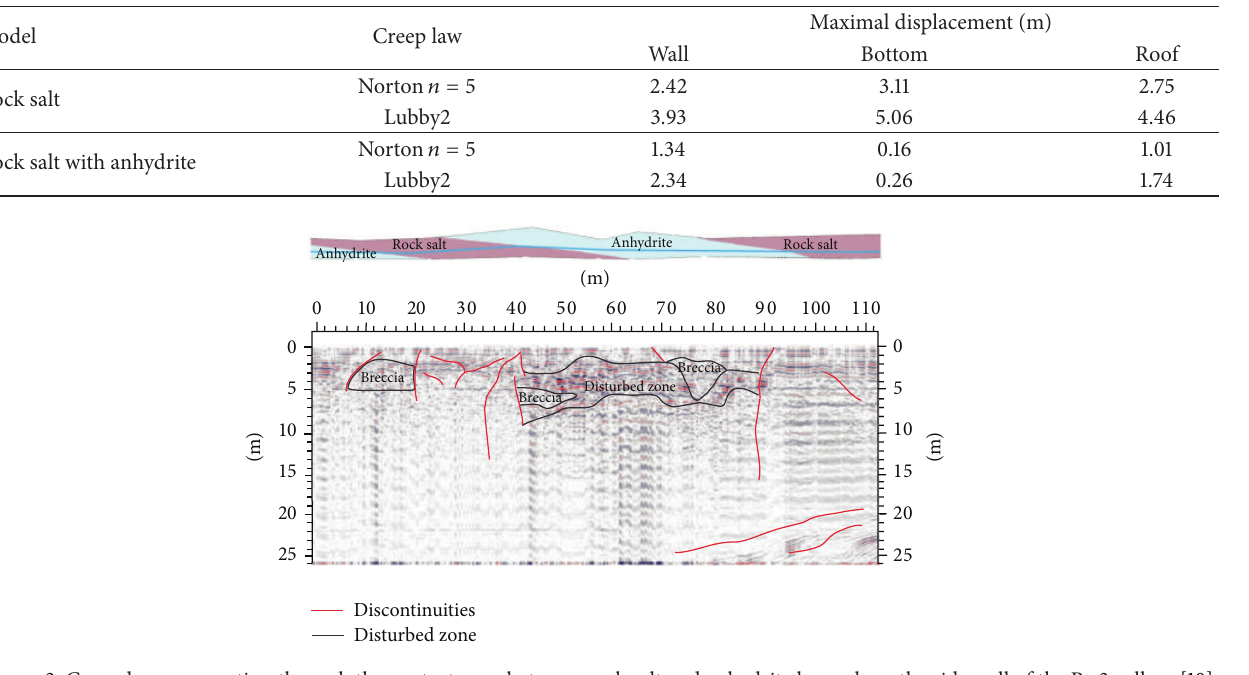
Table 5: Maximal horizontal displacement of chamber wall and vertical displacement of the chamber bottom and roof [10].